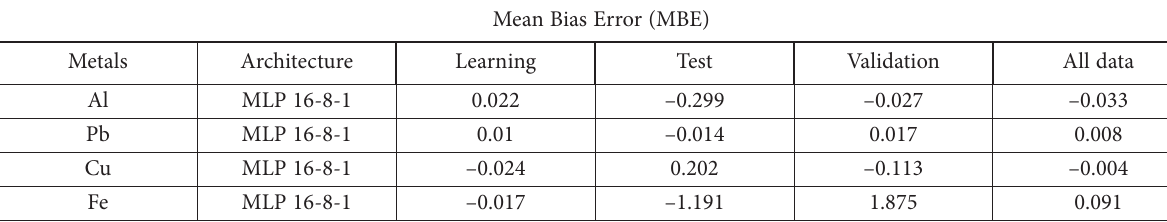
Table 6. MBE for the best topology of each heavy